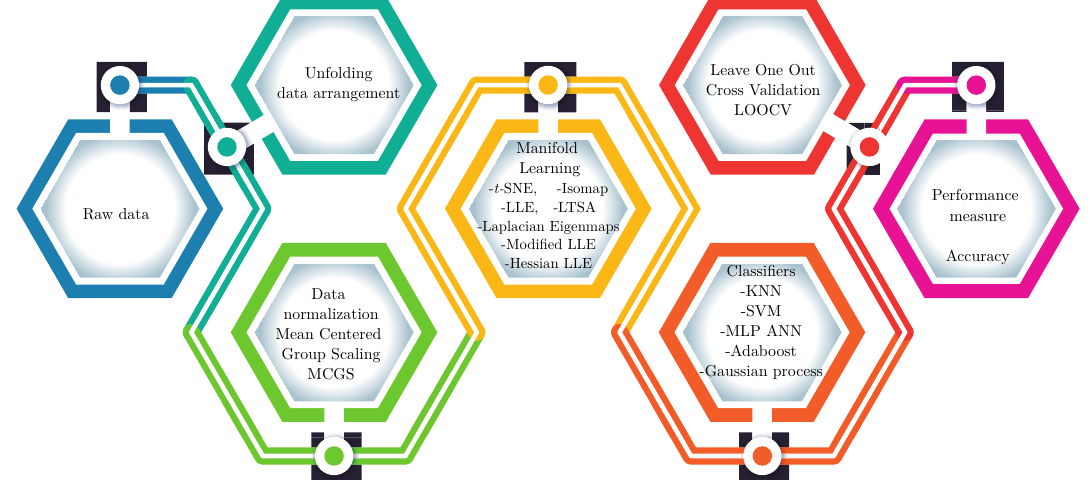
Figure 2. Manifold learning based artificial taste recognition